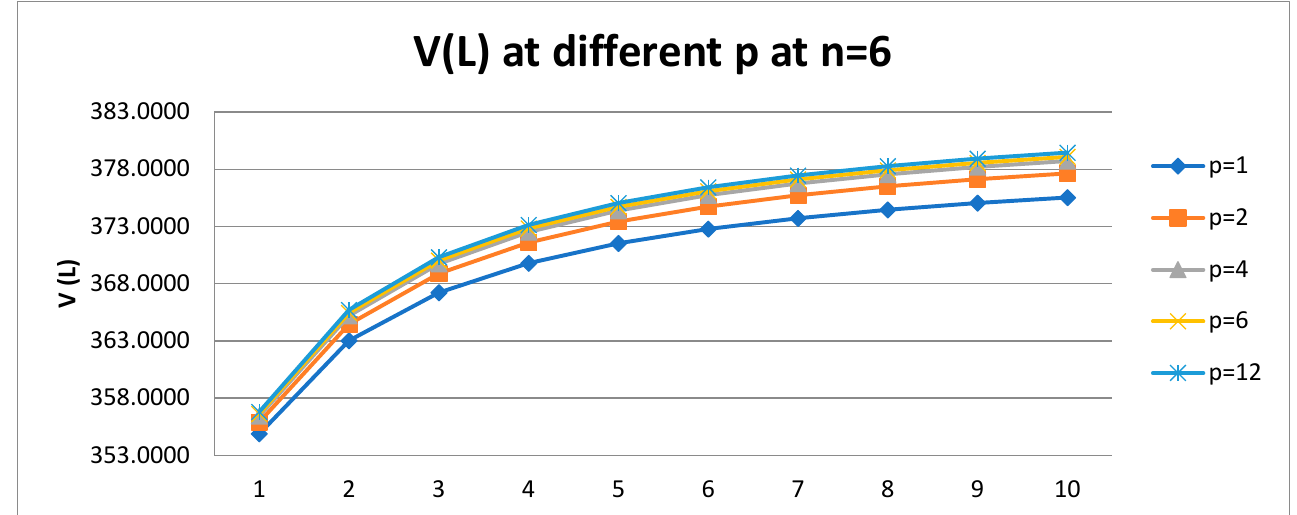
Figure 8. Dependence of the company value, V , on leverage level L at different frequency of payments of tax on profit p for six-year company.